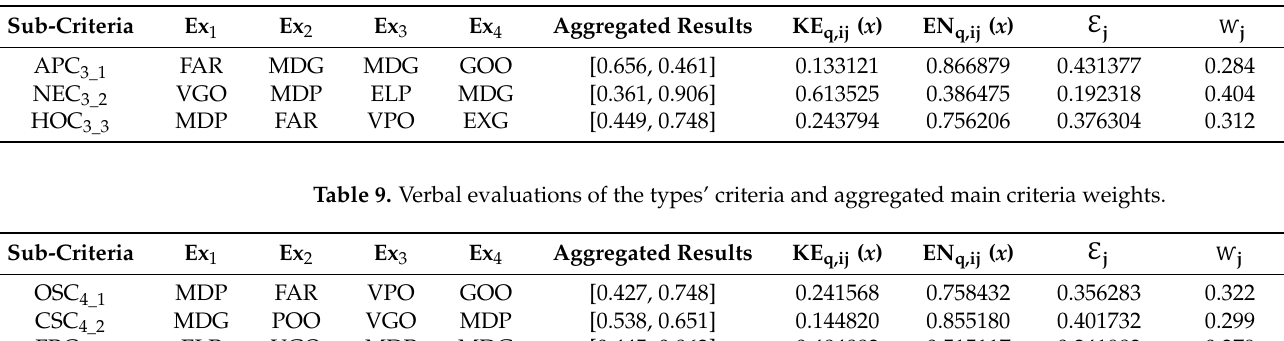
Table 8. Verbal evaluations of the targets’ criteria and aggregated main criteria weights.